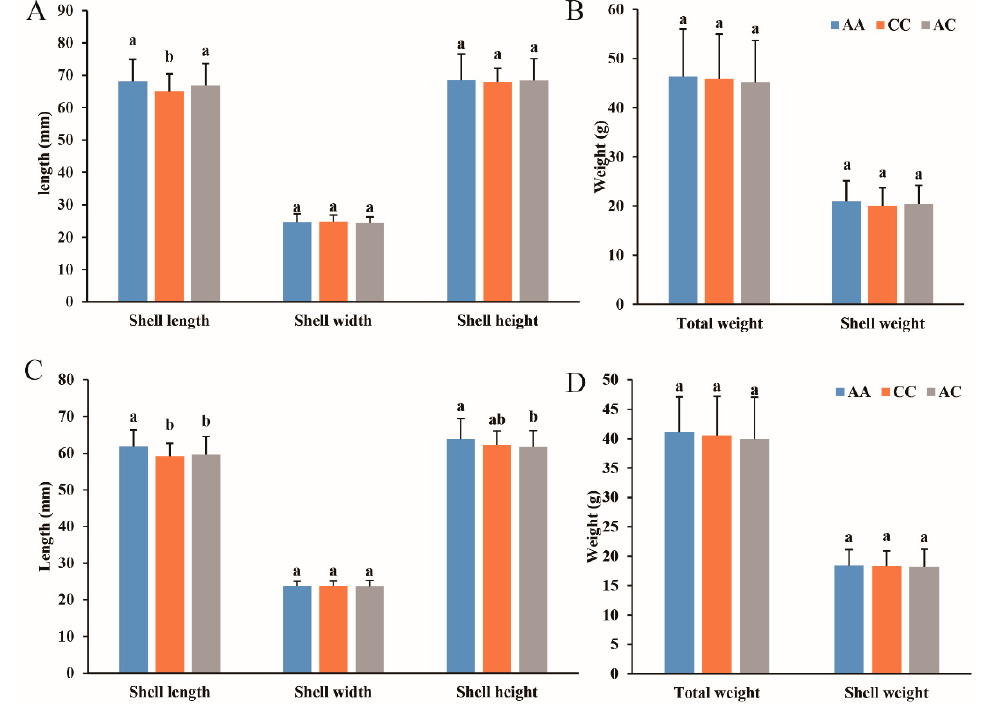
Figure 3. SNP g.50918198A > C verification in two lines. ( A , B ) and ( C , D ) showed the result of the “Haixuan NO1” and yellow shell color line, respectively. Bars with different letters indicate significant differences among different genotypes ( P < 0.05).